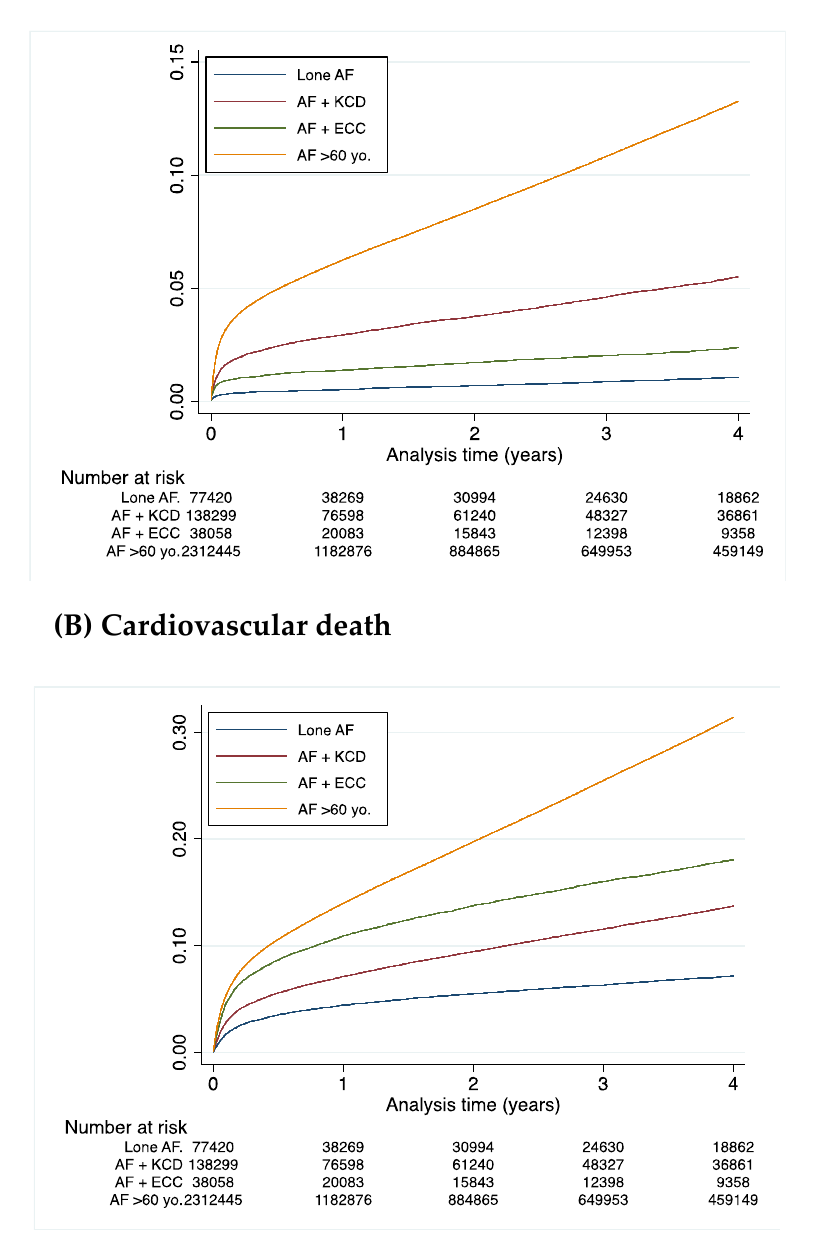
Figure 2. Cumulative incidences of all-cause death ( A ), cardiovascular death ( B ), or non- cardiovascular death ( C ) during follow-up in patients with AF (< 60 years old) (KCD: known cardiac disease; ECC: extra-cardiac comorbidities).